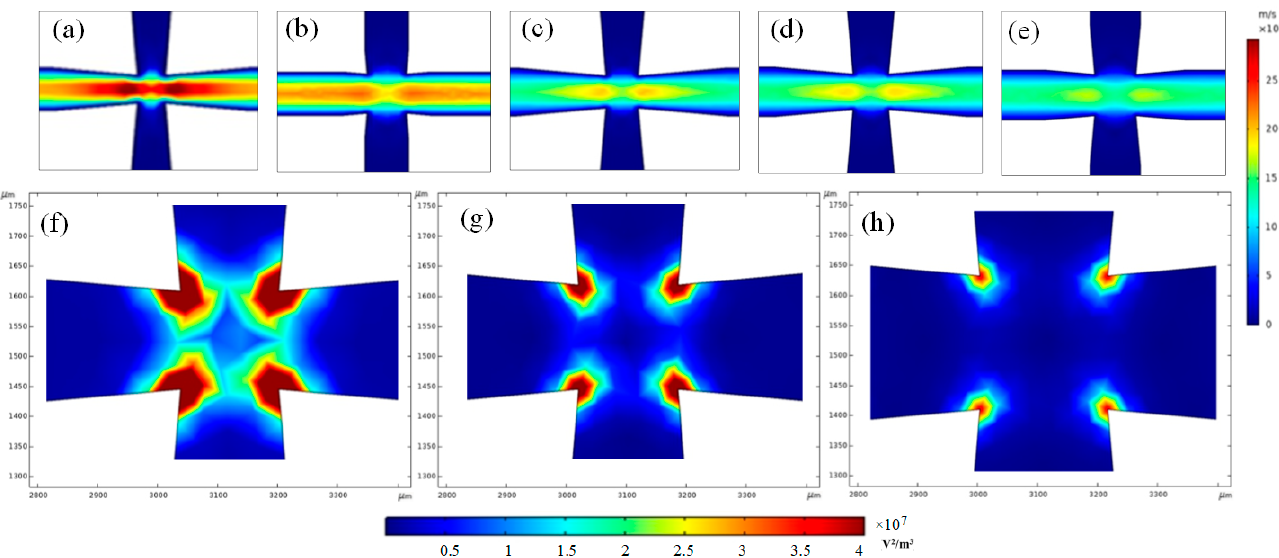
Figure 4. Numerical simulation of different channel widths; ( a – e ) represent the simulation of the flow field with channel widths of 100 µ m, 150 µ m, 200 µ m, 250 µ m, and 300 µ m; ( f – h ) represent the simulation of electric field intensity gradient with the channel widths of 200 µ m, 250 µ m, and 300 µ